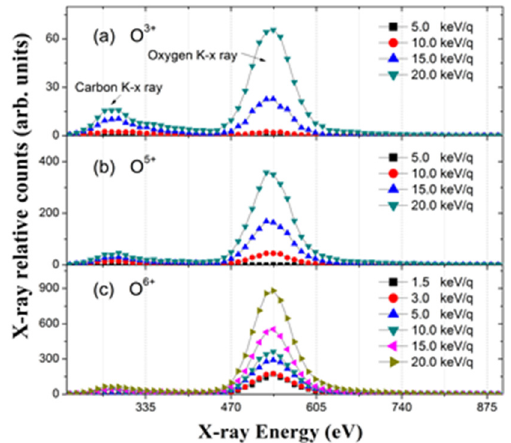
Figure 1. X-ray spectra induced by different kinetic energy O q+ (q = 3, 5, 6) ions impinging on the Cu surface. ( a ) O 3+ ions with incident energy range from 5 to 20 keV/q; ( b ) O 5+ ions from 5 to 20 keV/q; ( c ) O 6+ ions from 1.5 to 20 keV/q.